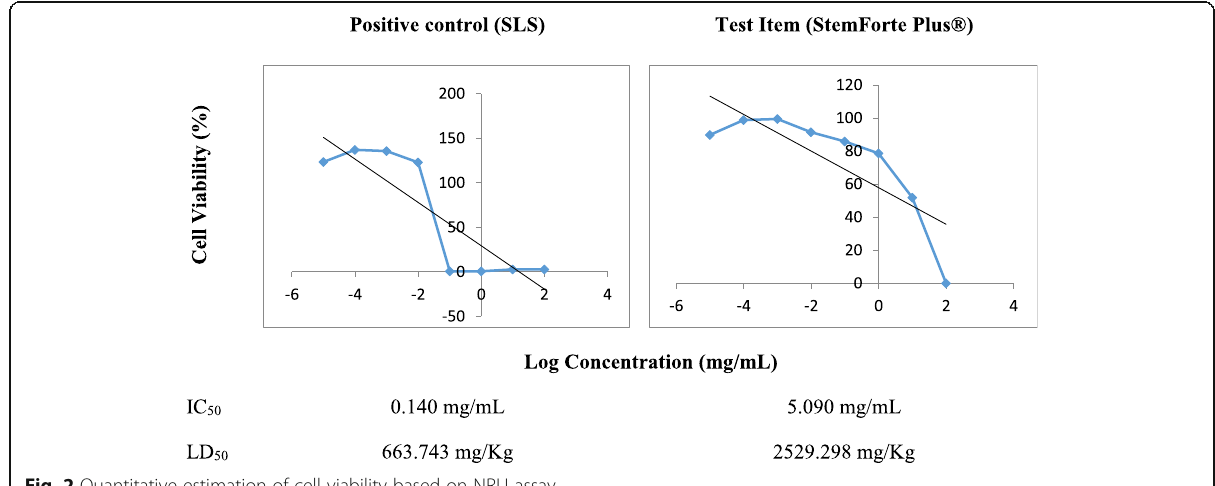
Fig. 2 Quantitative estimation of cell viability based on NRU assay